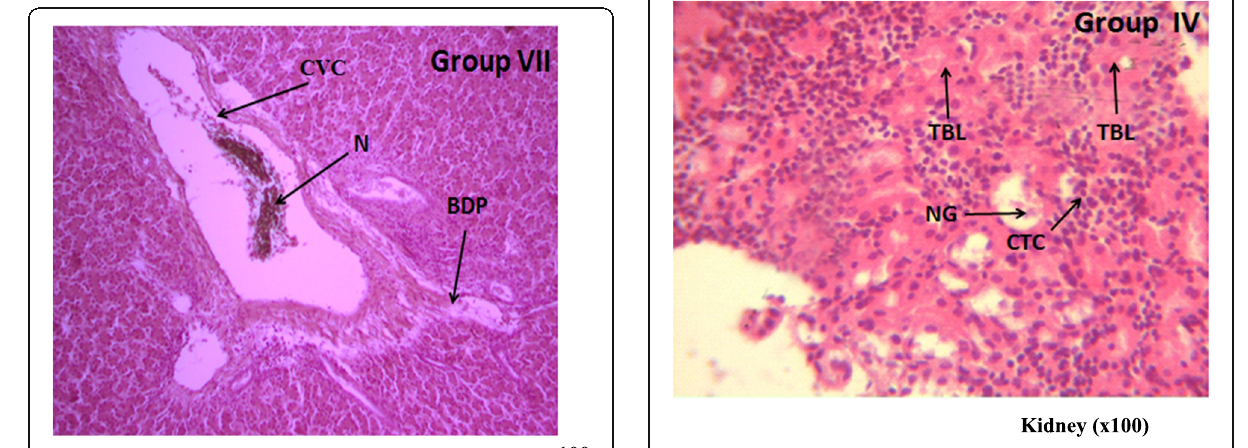
Fig. 5 Photomicrograph of the kidney from a bird in group IV at the end of 12 weeks of direct exposure to 3 mg CN kg − 1 body weight.